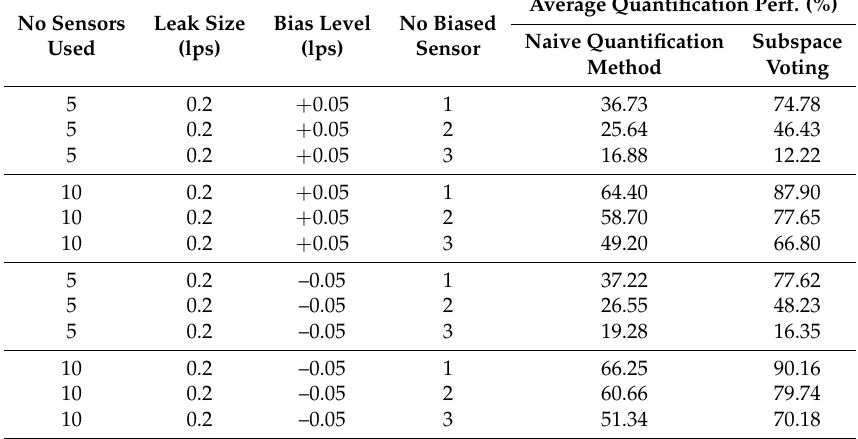
Table 6. Comparison of quantification performances between the use of naive quantification method and vector subspace voting for single